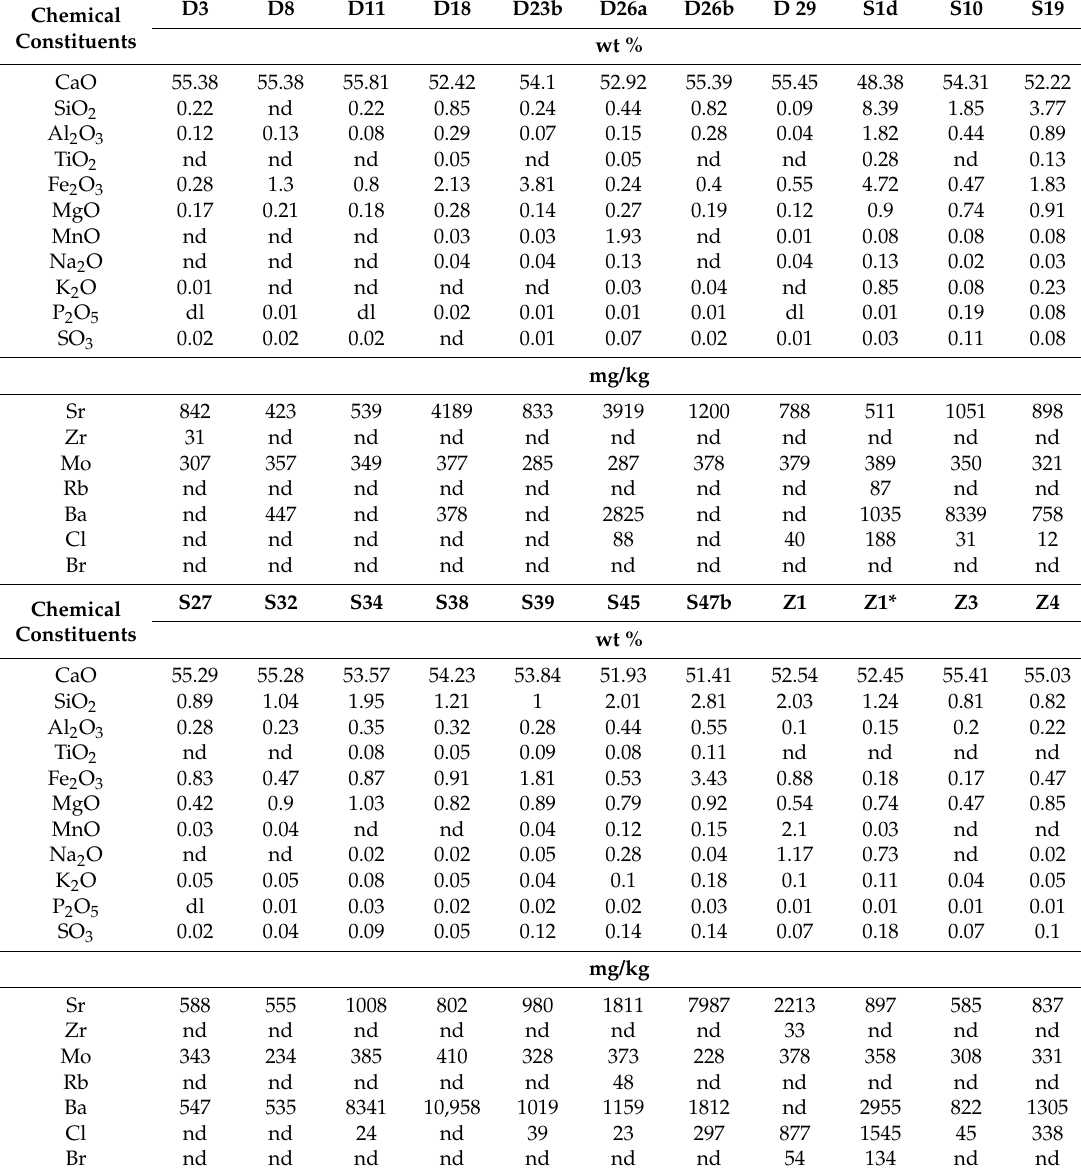
Table 3. X-ray Fluorescence results of major and minor elements of travertine and tufa